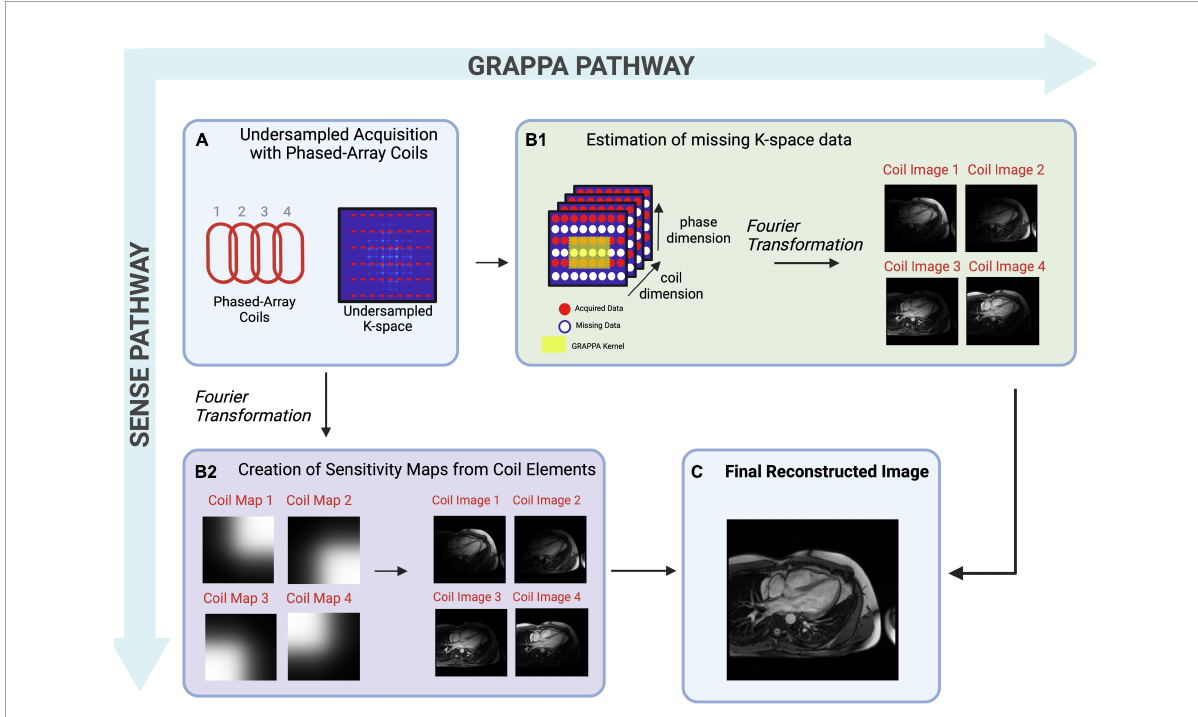
FIGURE3 A pictorial example of multi-coil Parallel Imaging techniques describing both image-based SENSE (sensitivity encoding) or k-space based GRAPPA (generalized autocalibrating partial parallel acquisition)– two differing reconstruction techniques. (A) Pictorial representation of phased-array coils used to acquire undersampled data, and a graphical representation of undersampled k-space. The non-random undersampling method results in artifacts that are detrimental to visual inspection, therefore must be separated from real signals. (B1) Pictorial representation of k-space based GRAPPA. In this technique, reconstruction takes place in the k-space. The acquired MR signals fill in k-space for each coil, though many lines of k-space are missing due to undersampling. Missing points in k-space are then estimated iteratively using known data from the center of k-space, and local known data for each region, known as kernels. Once missing lines of k-space are filled, a Fourier transformation is performed, creating individual coil images from which the final reconstructed image will be created. (B2) Pictorial representation of image-based SENSE, in which reconstruction takes place in image space. A Fourier Transformation is performed which creates a coil sensitivity map for each coil element. These sensitivities are used to sort real signals from artifacts, creating an image for each coil, from which the final reconstructed image will be created. (C) The individual coil images are combined to create a final, reconstructed